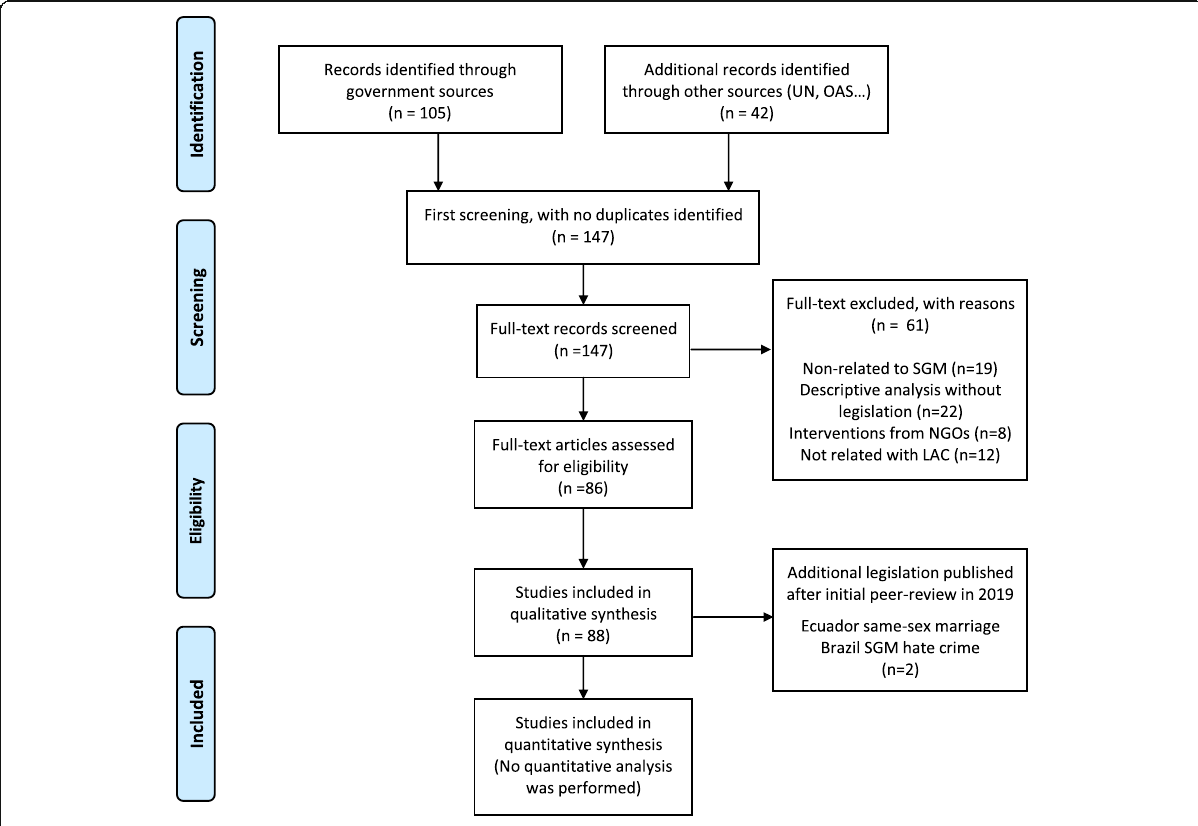
Fig. 1 Overview of the search strategy according to the PRISMA